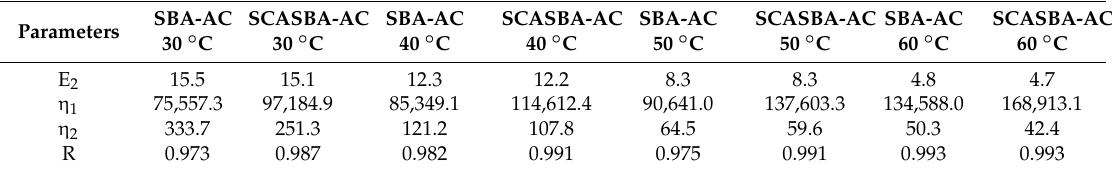
Table 9. Dynamic creep Burger’s model parameters of asphalt mixture under different temperatures.